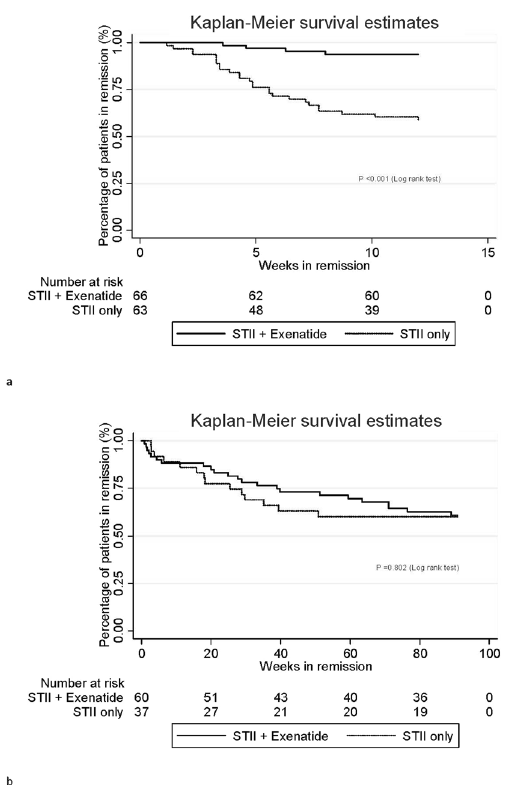
Figure 2. Cumulative probability of remission ( a ). During the 12-week exenatide treatment after STII therapy; ( b ). From the 13th week to 2 years of follow-up after STII